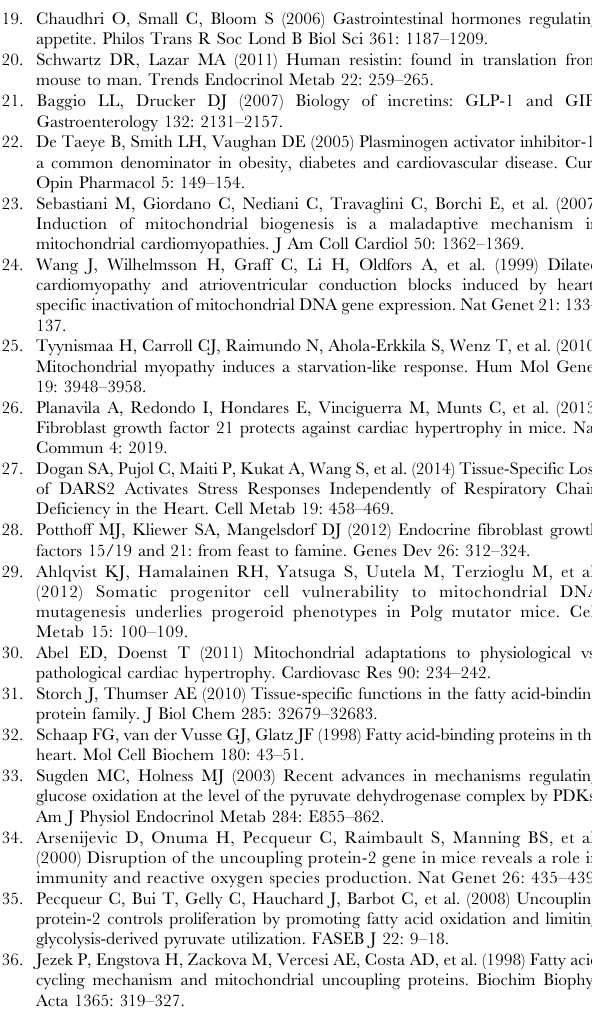
Table S1 Statistical analysis of results by one-way ANOVA analysis. Measurements were performed on wild type (wt), mtDNA mutator (mut), UCP2-deficient wild type (ko) and mtDNA mutator mice (dm) mice. Asterisks indicate level of statistical significance Table S2 List of primers used for quantitative real-time PCR analysis using Brilliant III Ultra-Fast SYBR Green QPCR Master Mix (Agilent